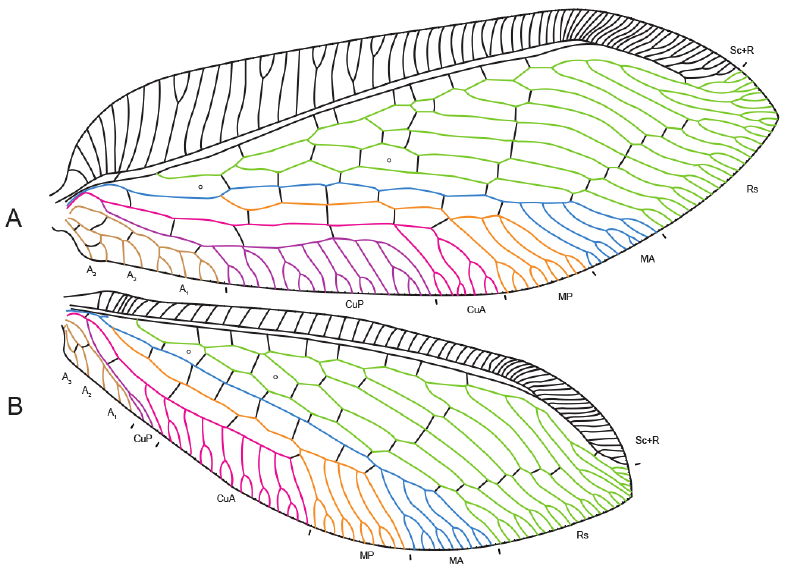
Figure 4. Wing venation of Gryposmylus pennyi sp. n.: A forewing B hind wing. Major wing veins are colour